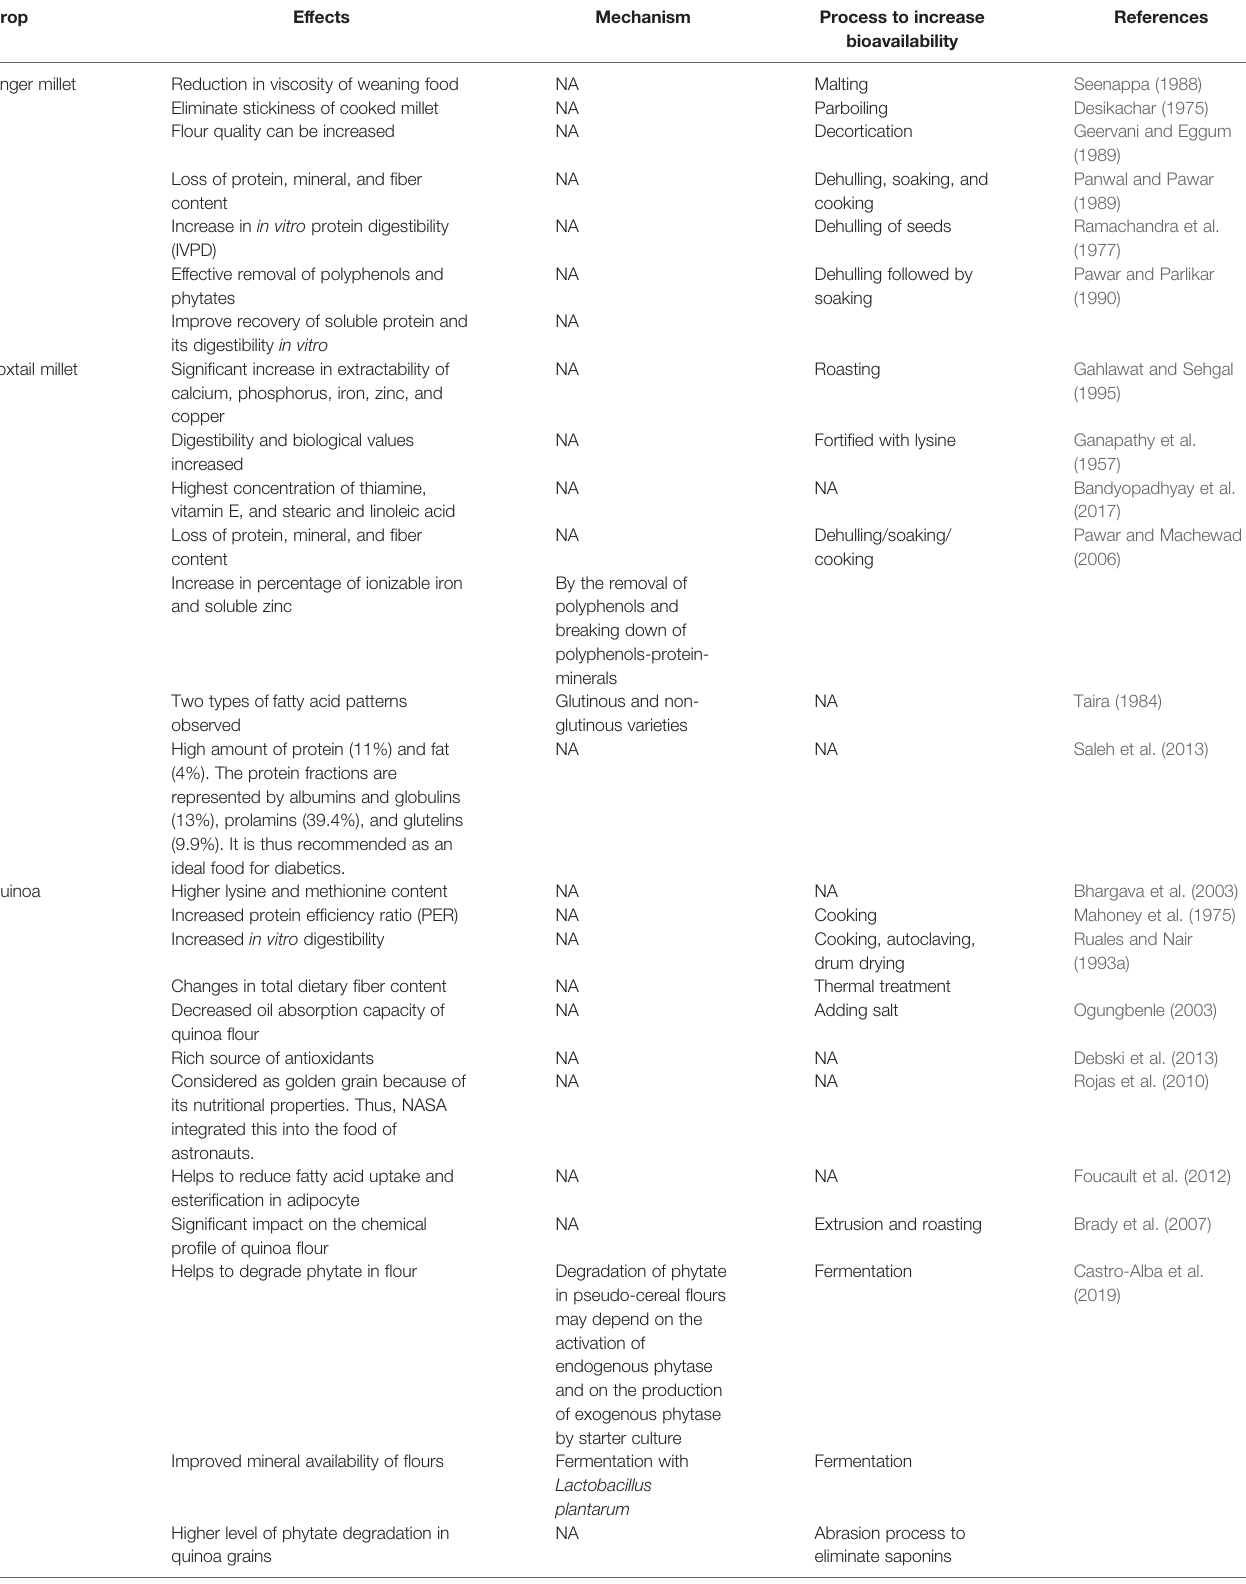
TABLE 5 | Effects, mechanism, and process of increasing bioavailability of cereals and pseudo-cereal grains.